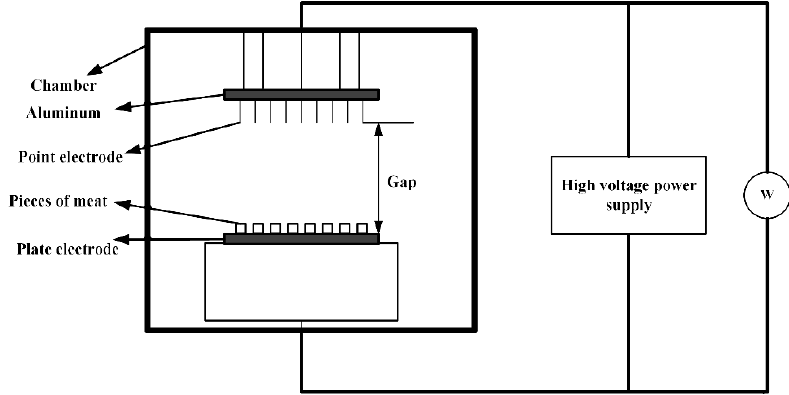
Figure 4. The schematic diagram of high-voltage electrostatic field thawing technology.